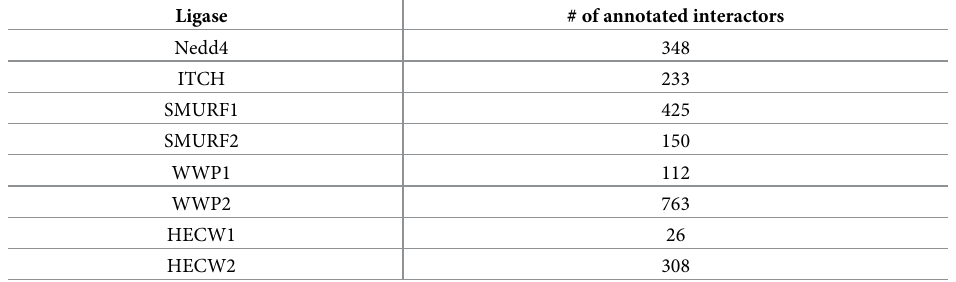
Table 1. Number of previously identified interactors for each Nedd4 family ligase in the BioGrid protein-protein interaction